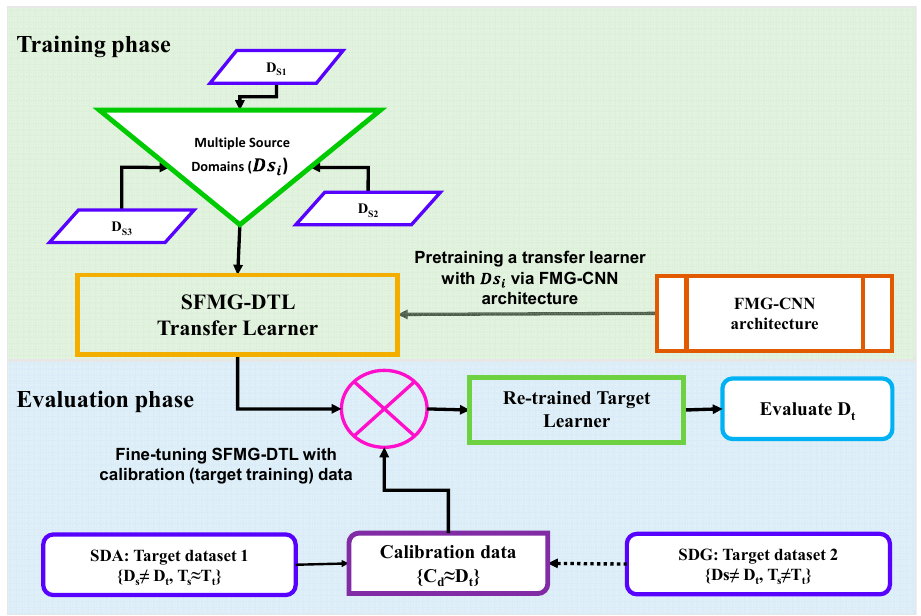
Figure 5. SFMG-DTL: unified transfer learning framework for SDA and SDG. Table 2. Source and target